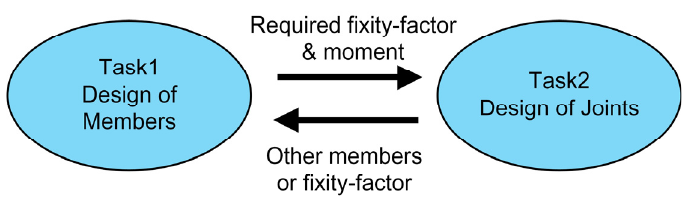
Figure 3. Data interaction between two tasks.